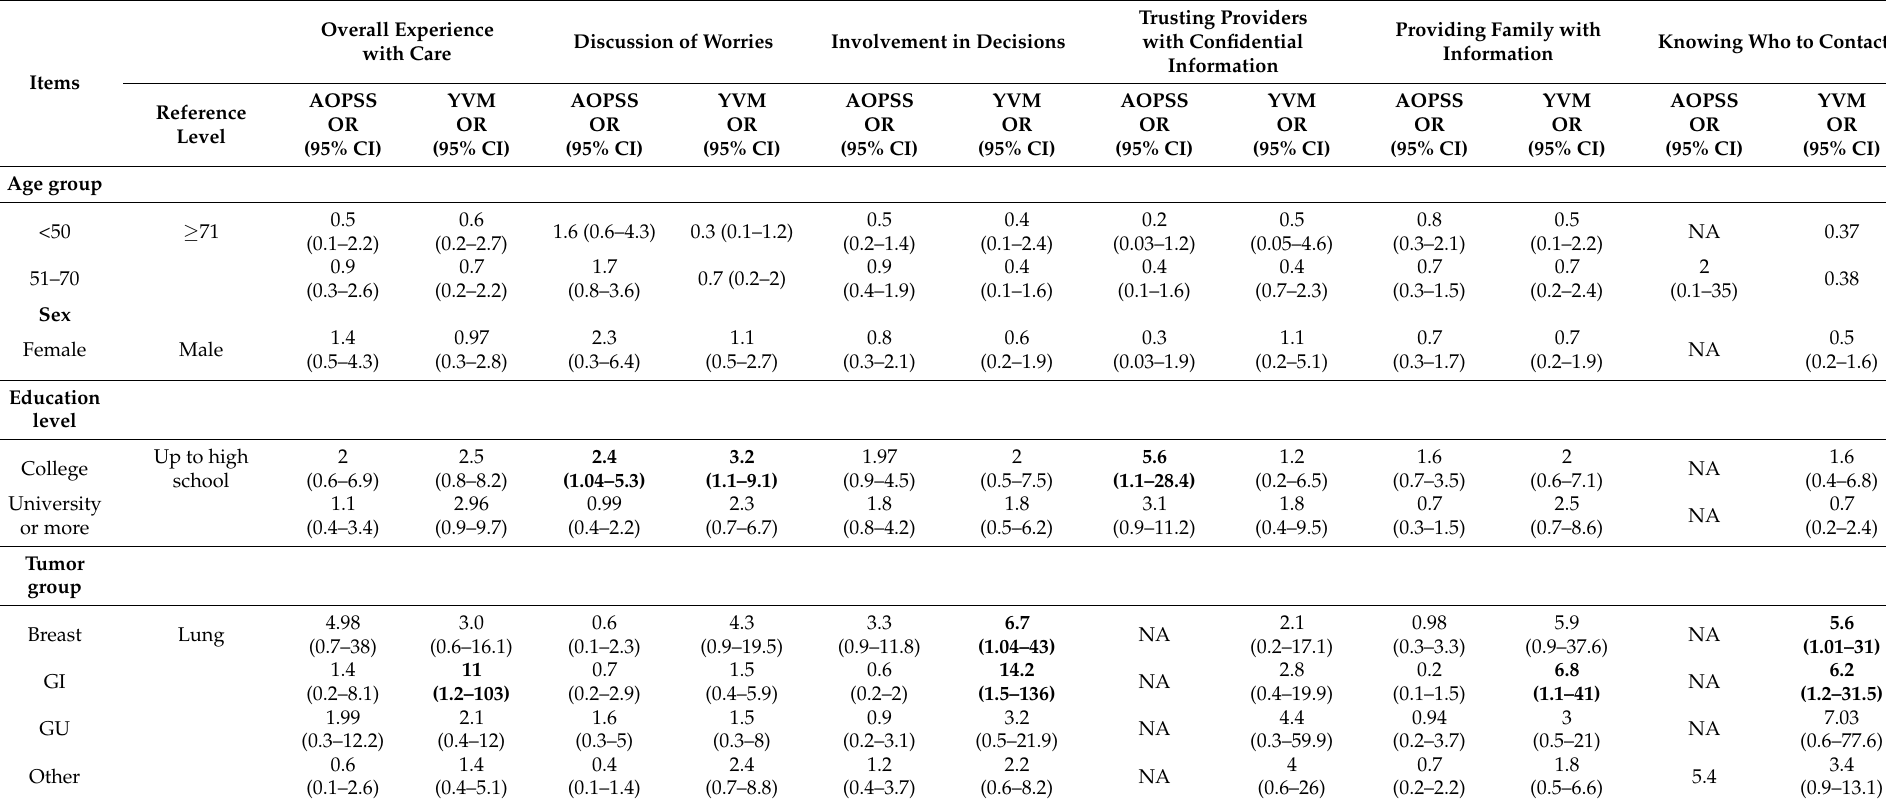
Table 4. Results of Multivariable Logistic Regression Model for Similar Experience Items from AOPSS and